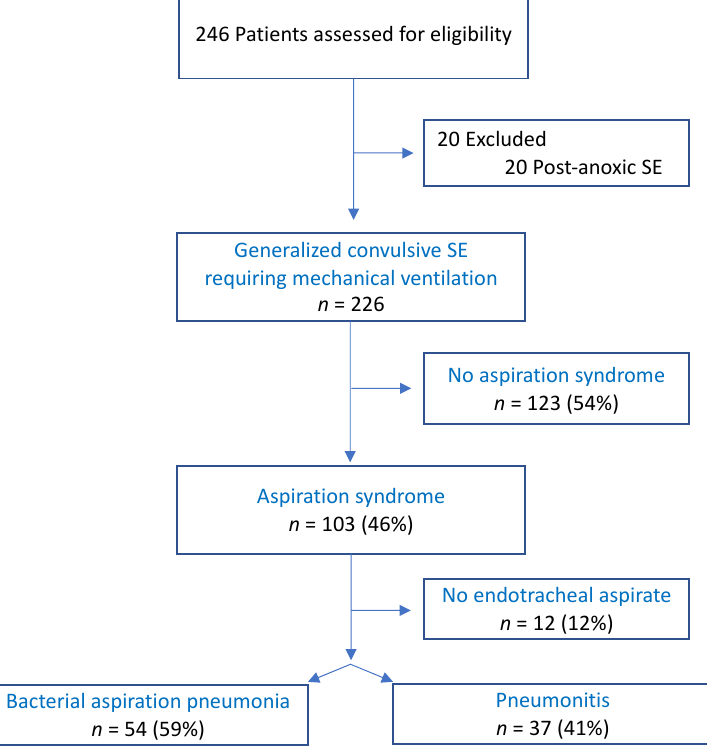
Figure 1. Flowchart. Abbreviations: SE, status epilepticus.